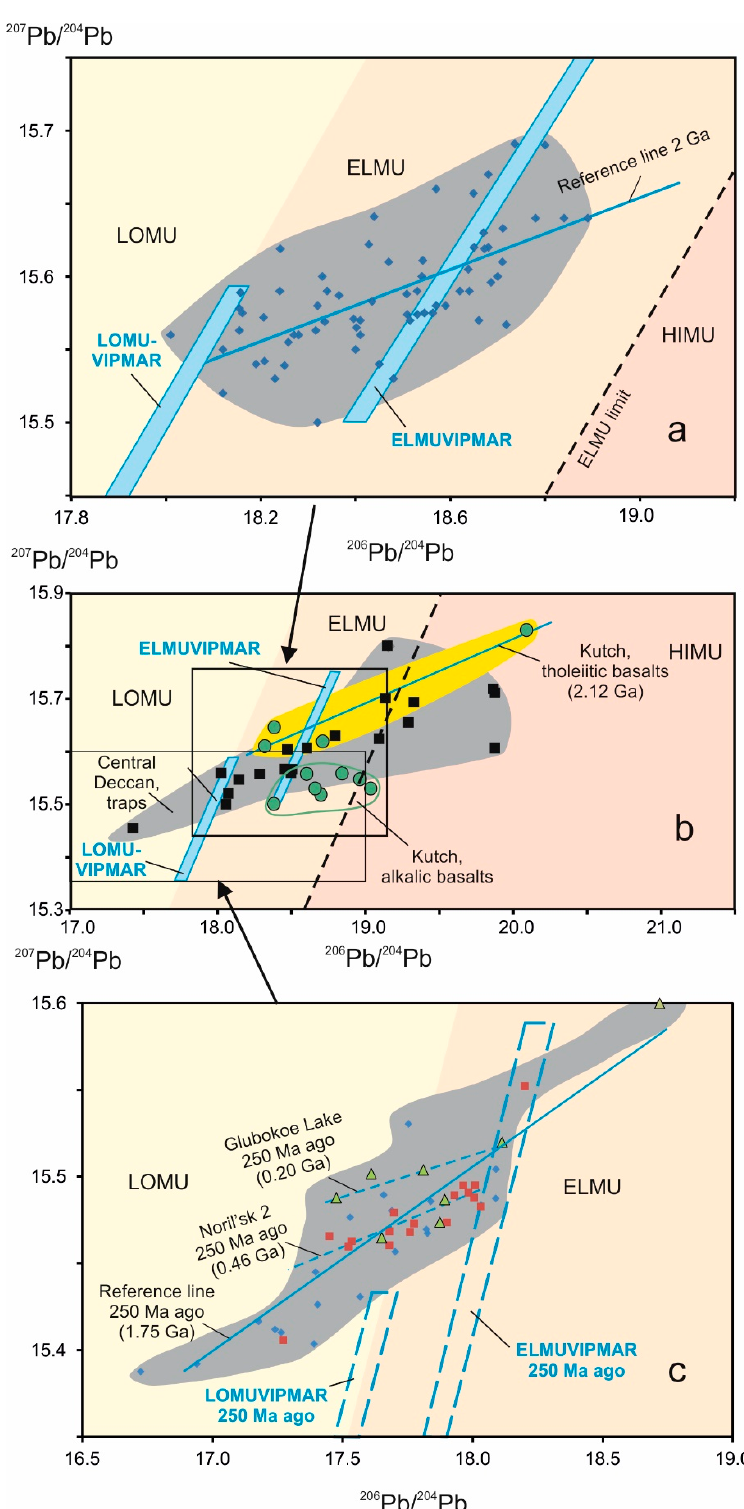
Figure 10. Diagrams of 207 Pb/ 204 Pb versus 206 Pb/ 204 Pb for volcanic and intrusive rocks from Indochina ( a ), Indian paleocontinent ( b ), and Siberian paleocontinent (Noril’sk area) ( c ). In diagrams a and b, the LOMUVIPMAR and ELMUVIPMAR compositions, as well as LOMU – ELMU and ELMU limit discriminating lines are shown as in Figure 5. In diagram c, data points of traps and viscous protomantle compositions correspond to the age of 250 Ma. Calculation of the secondary isochron 0.46 Ga was performed using the Isoplot program [87]. Data are from [41,94,98,100,101,102,103,104,105,106,107,108].